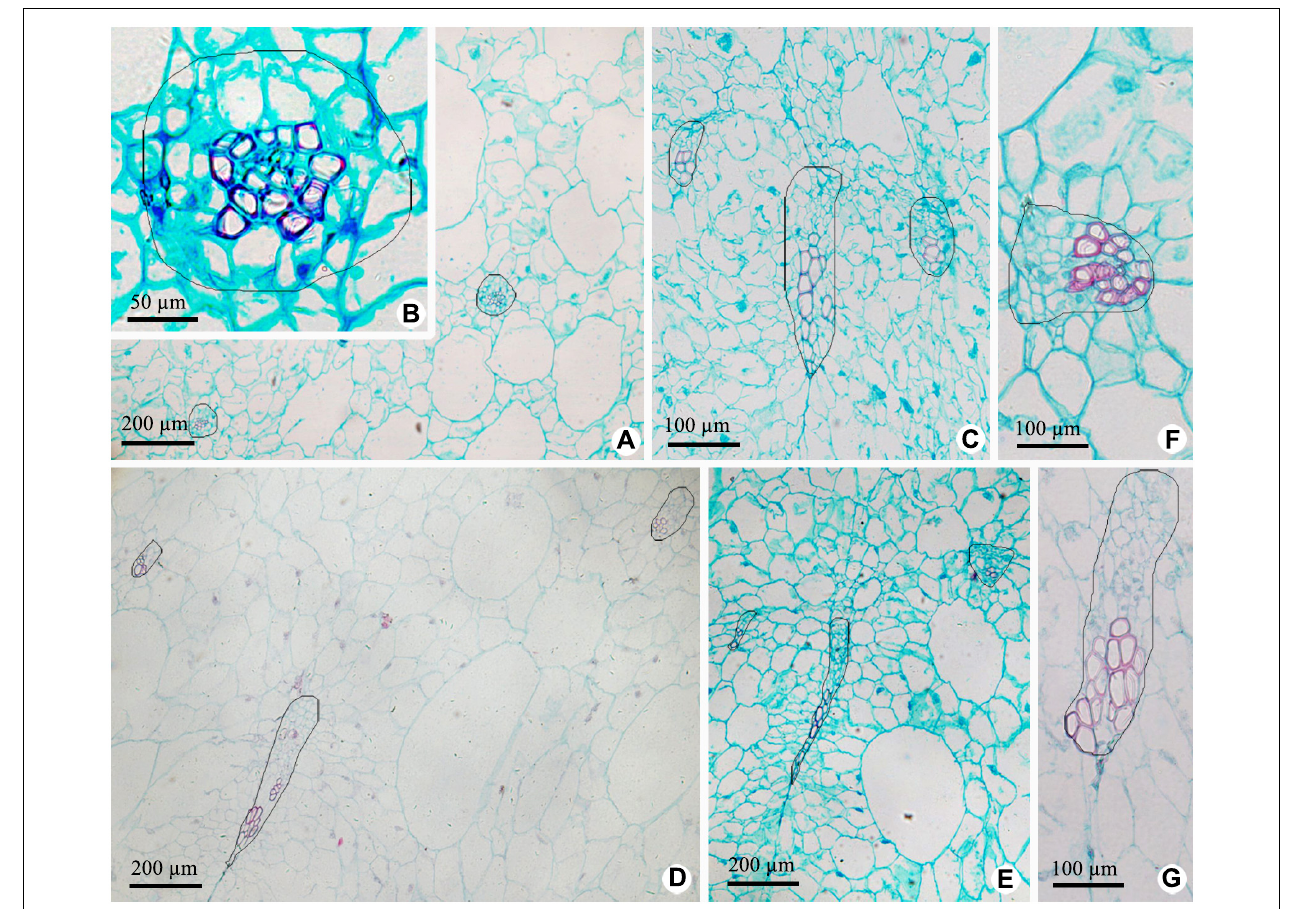
FIGURE 4 | Cross sections of outer pericarp at the base, in the middle and near the top of fruits. (A–C) Views at the base. (A) Cross section of outer pericarp, showing two amphicribral bundles from lateral branch bundles. (B) Detailed view of the amphicribral bundle on the right side of Figure 4A . (C) Cross section of outer pericarp, showing three collateral bundles and their different shapes, which are all ovary wall vascular bundles. (D,E) Views in the middle. (D) Cross section of outer pericarp,